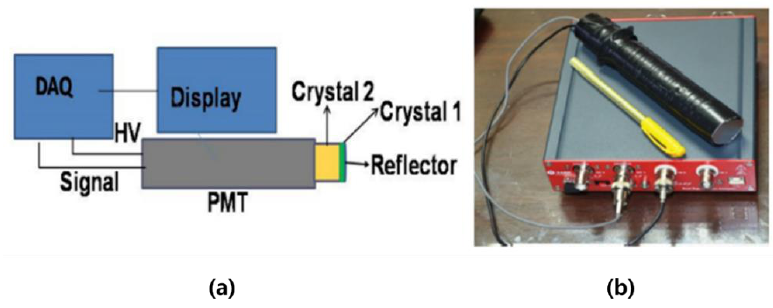
Figure 29. ( a )The scheme and ( b ) actual setup of the Phoswich detector [62].